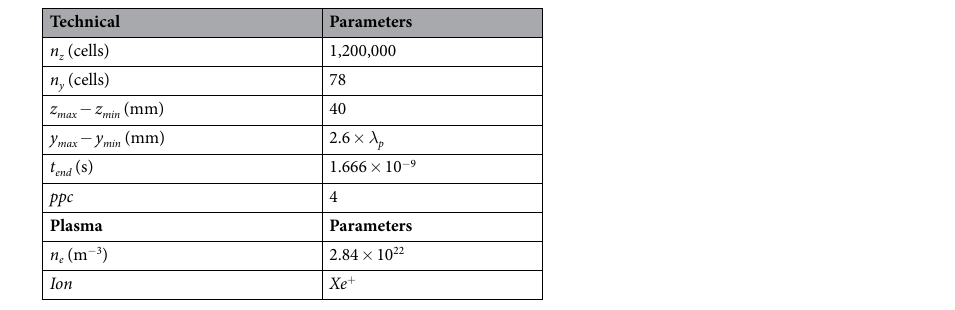
Table 5. Full final simulation parameters. n z is the grid cell length, n y is the grid cell width, z max − z min is the grid length,